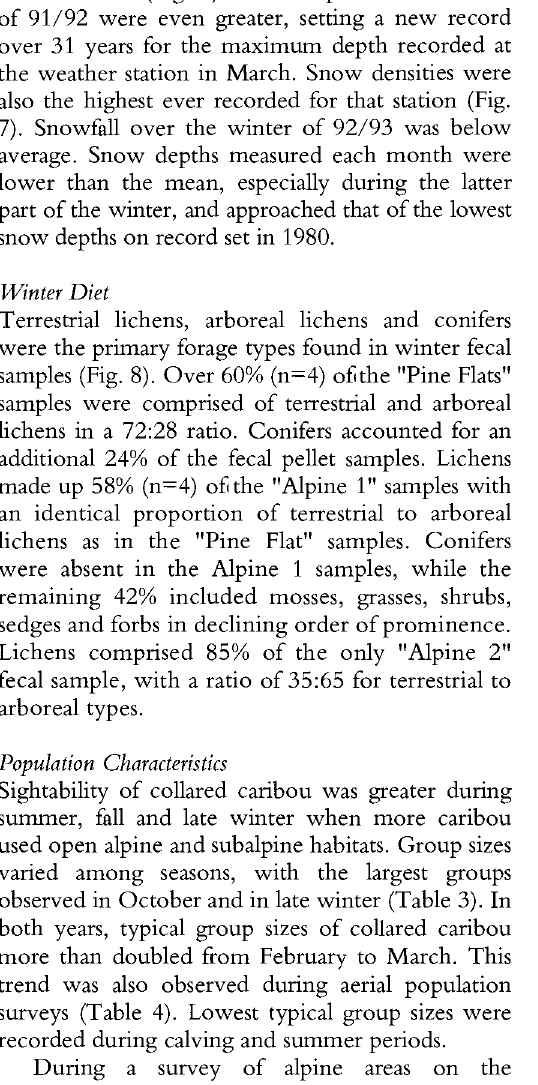
Fig. 6. Snow depths measured at Germansen Snow Station (1500 metres). Mean snow depths based on 31 years data with exception of January (10 years) and February (24 years).